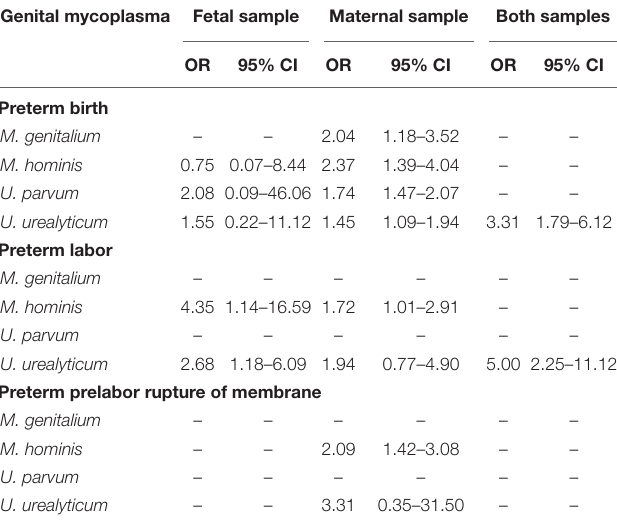
TABLE 2 | Subgroup analysis of the association (odds ratio) of genital mycoplasma with preterm birth (PTB), preterm labor (PTL), and preterm prelabor rupture of membranes (PPROM) based on the specimen used to detect genital mycoplasma. Genital mycoplasma Fetal sample Maternal sample Both samples